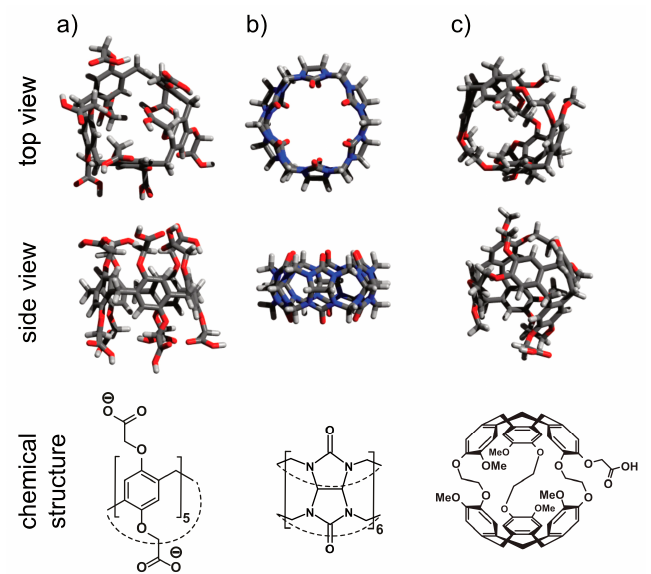
Figure 10. Comparison of Xe hosts: ( a ) a water-soluble pillar[5]arene; ( b ) cucurbit[6]uril (CB6); ( c ) cryptophane-A-monoacid (CryA-ma). Reproduced with permission by Wiley & Sons from ChemPhysChem 20, 246–251 (2019).